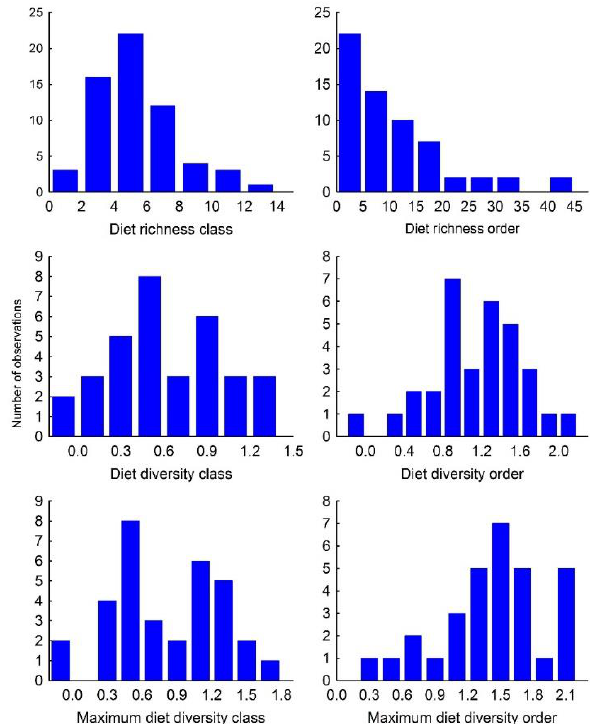
Figure 1. Frequency distribution of diet richness, diet diversity and maximum diet diversity at class ( left ) and order ( right ) taxonomic ranks of Falconidae species.